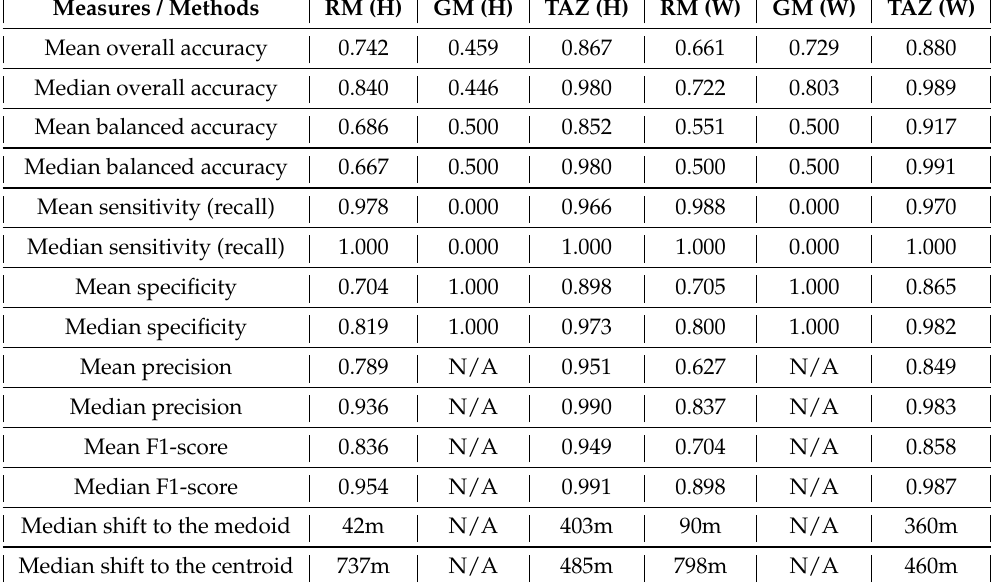
Table 1: The geoprivacy effectiveness measures using different geomasking methods (Ran- dom perturbation with 1km threshold and Gaussian perturbation with 0.05 SD; H: Home, W: Work, GM: Gaussian Masking, RM: Random Masking, TAZ: Aggregation by traffic anal- ysis zones, and N/A means results are not